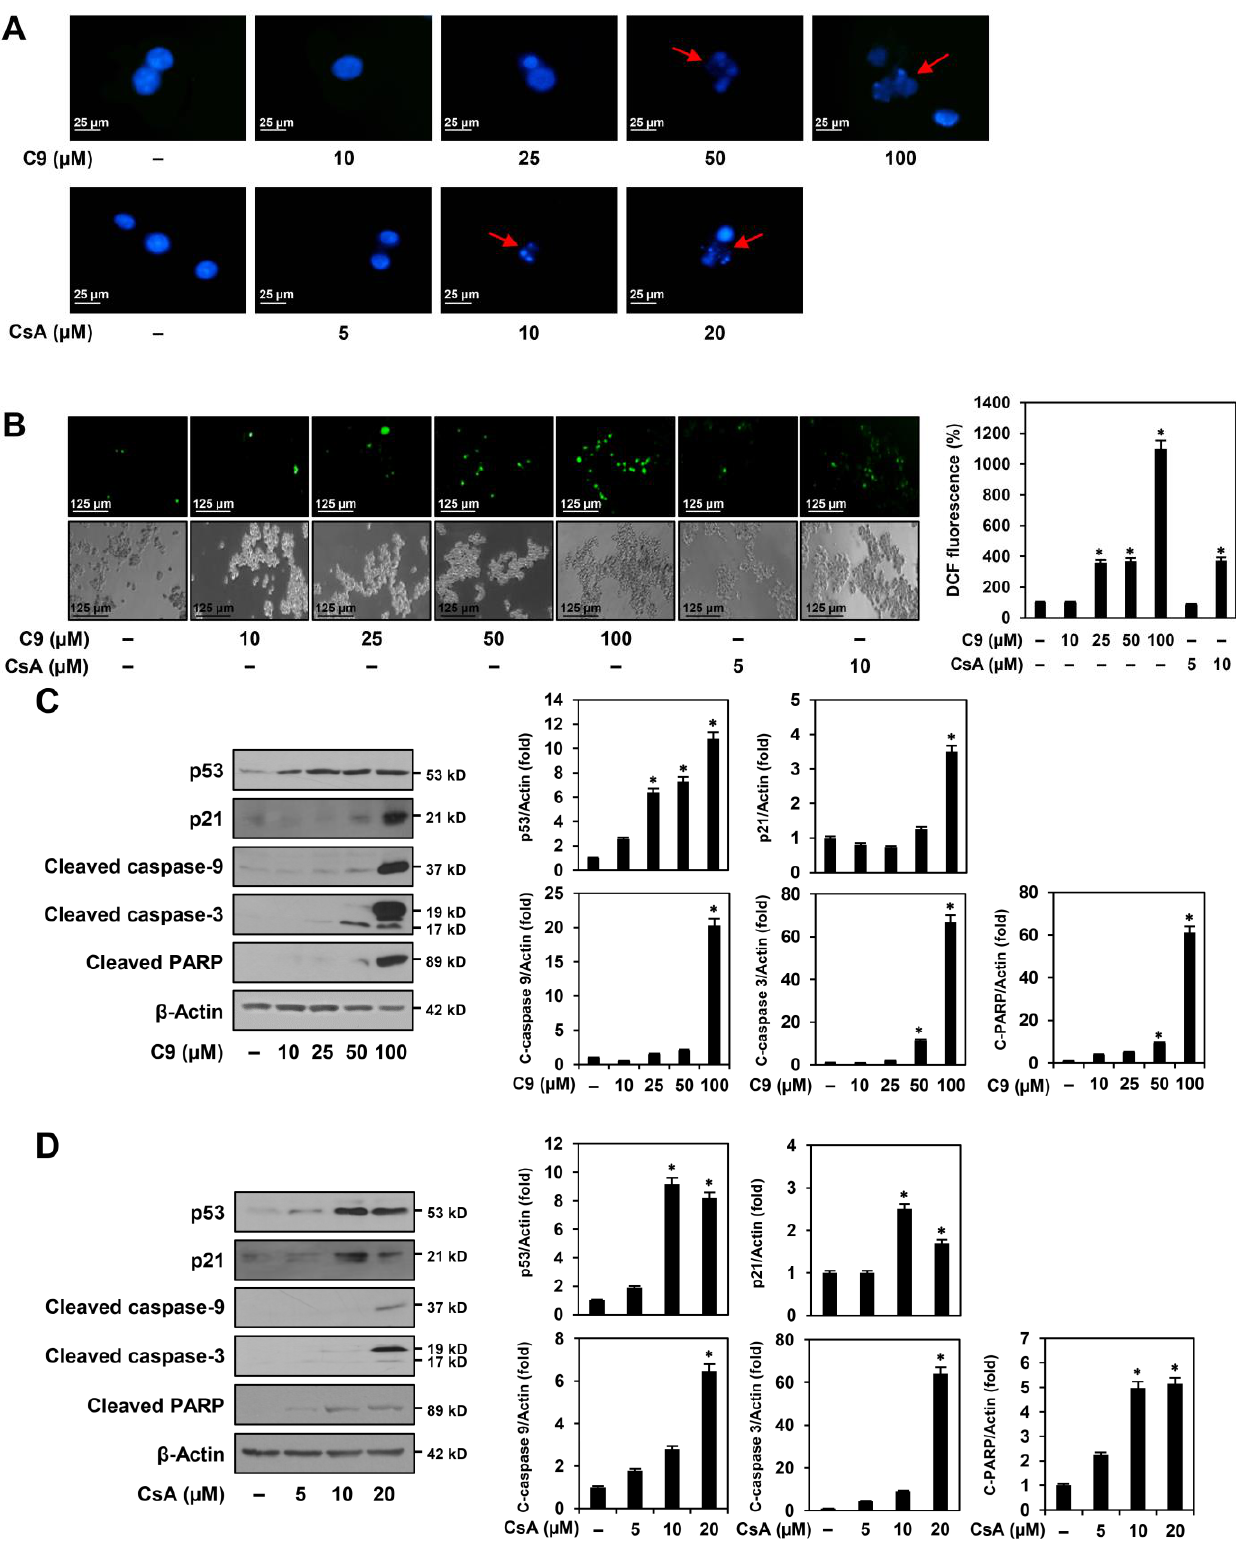
Figure 7. Effects of C9 and CsA on the apoptotic characteristics of MKN45 GCSCs. ( A ) Effects of C9 and CsA on nuclear morphology. MKN45-derived GCSCs were treated with the indicated concentrations of each compound for 72 h. Changes in nuclear morphology were monitored via DAPI staining under a fluorescence microscope. The condensed and fragmented nuclei are indicated by red arrows. ( B ) Effects of C9 and CsA on intracellular ROS generation. MKN45-derived GCSCs were treated with the indicated concentrations of each compound for 6 h. ROS levels were detected with H 2 DCFDA using a fluorescence microscope and were further quantified via densitometry. The level of DCF fluorescence for untreated control was normalized to 100%. ( C , D ) Effects of C9 and CsA on the expression of apoptosis regulators. MKN45-derived GCSCs were treated with the indicated con- centrations of each compound for 72 h. Protein levels were detected via Western blot analysis using specific antibodies and were further quantified using densitometry. β -actin levels were used as an internal control. The ratio of each target protein to β -actin for untreated control was normalized to onefold. * p < 0.05 vs. the control. 2.4. C9 and CsA Affect CypA/CD147-Mediated Signaling Pathways in MKN45-Derived GCSCs Cyclophilin A and CD147 are overexpressed in various types of cancers, and CypA/CD147 interaction can activate multiple oncogenic signaling pathways, including phosphatidylinositol-3-kinase (PI3K)/AKT and MAPKs, thereby promoting the prolifera- tion, anti-apoptosis, metastasis, angiogenesis, drug resistance, and stemness of cancer cells [10,16,28]. To determine whether the anticancer activities of C9 and CsA against MKN45 GCSCs were associated with downregulation of the CypA/CD147 axis, we first investigated the effects of C9 and CsA on CypA and CD147 expression. As shown in Fig- ure 8A,B, the expressions of CypA and CD147 were reduced by treatment with C9 and CsA in a dose-dependent manner in MKN45 GCSCs. Next, we examined the effects of C9 and CsA on the activation of CypA/CD147-mediated downstream signaling effectors in- cluding AKT, ERK1/2, and p38. The results showed that C9 and CsA more effectively sup- pressed the expression levels of phosphorylated forms than unphosphorylated AKT,